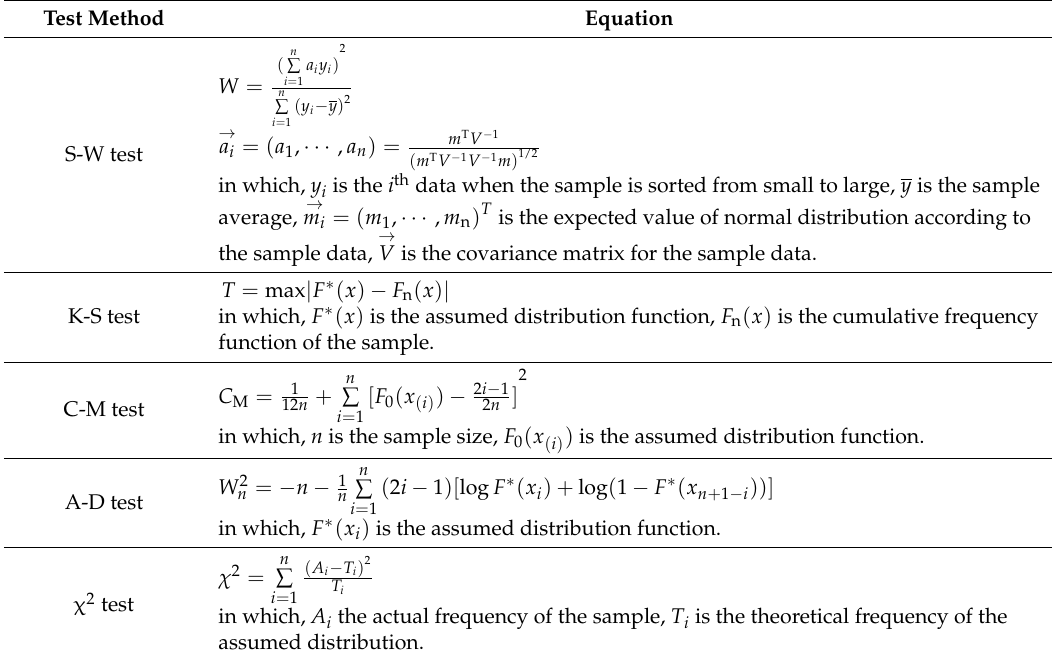
Table 2. The equations of five test methods.